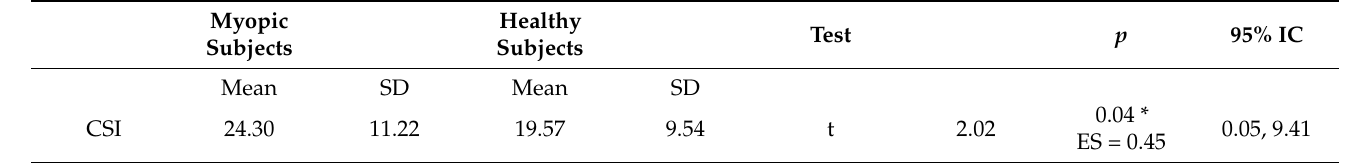
Table 2. Summary of ICS scores in myopic subjects and healthy subjects.